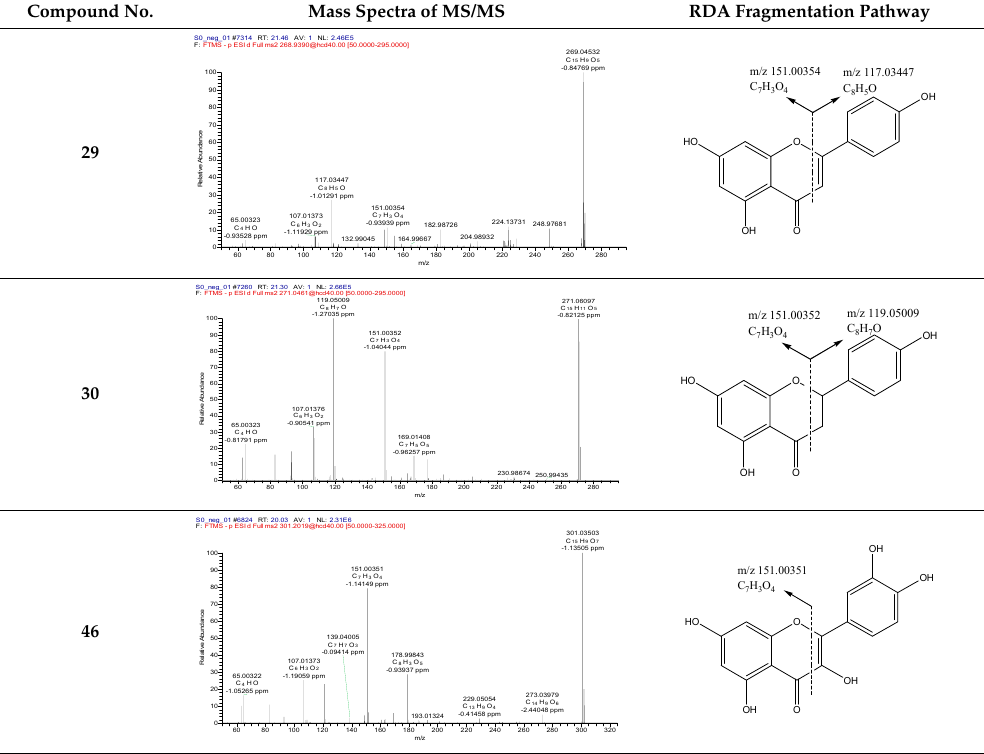
Figure 3. Fragmentation pattern I and II. Table 2. RDA fragmentation pathways of compound 29 , 30 , 46 , and 63 .